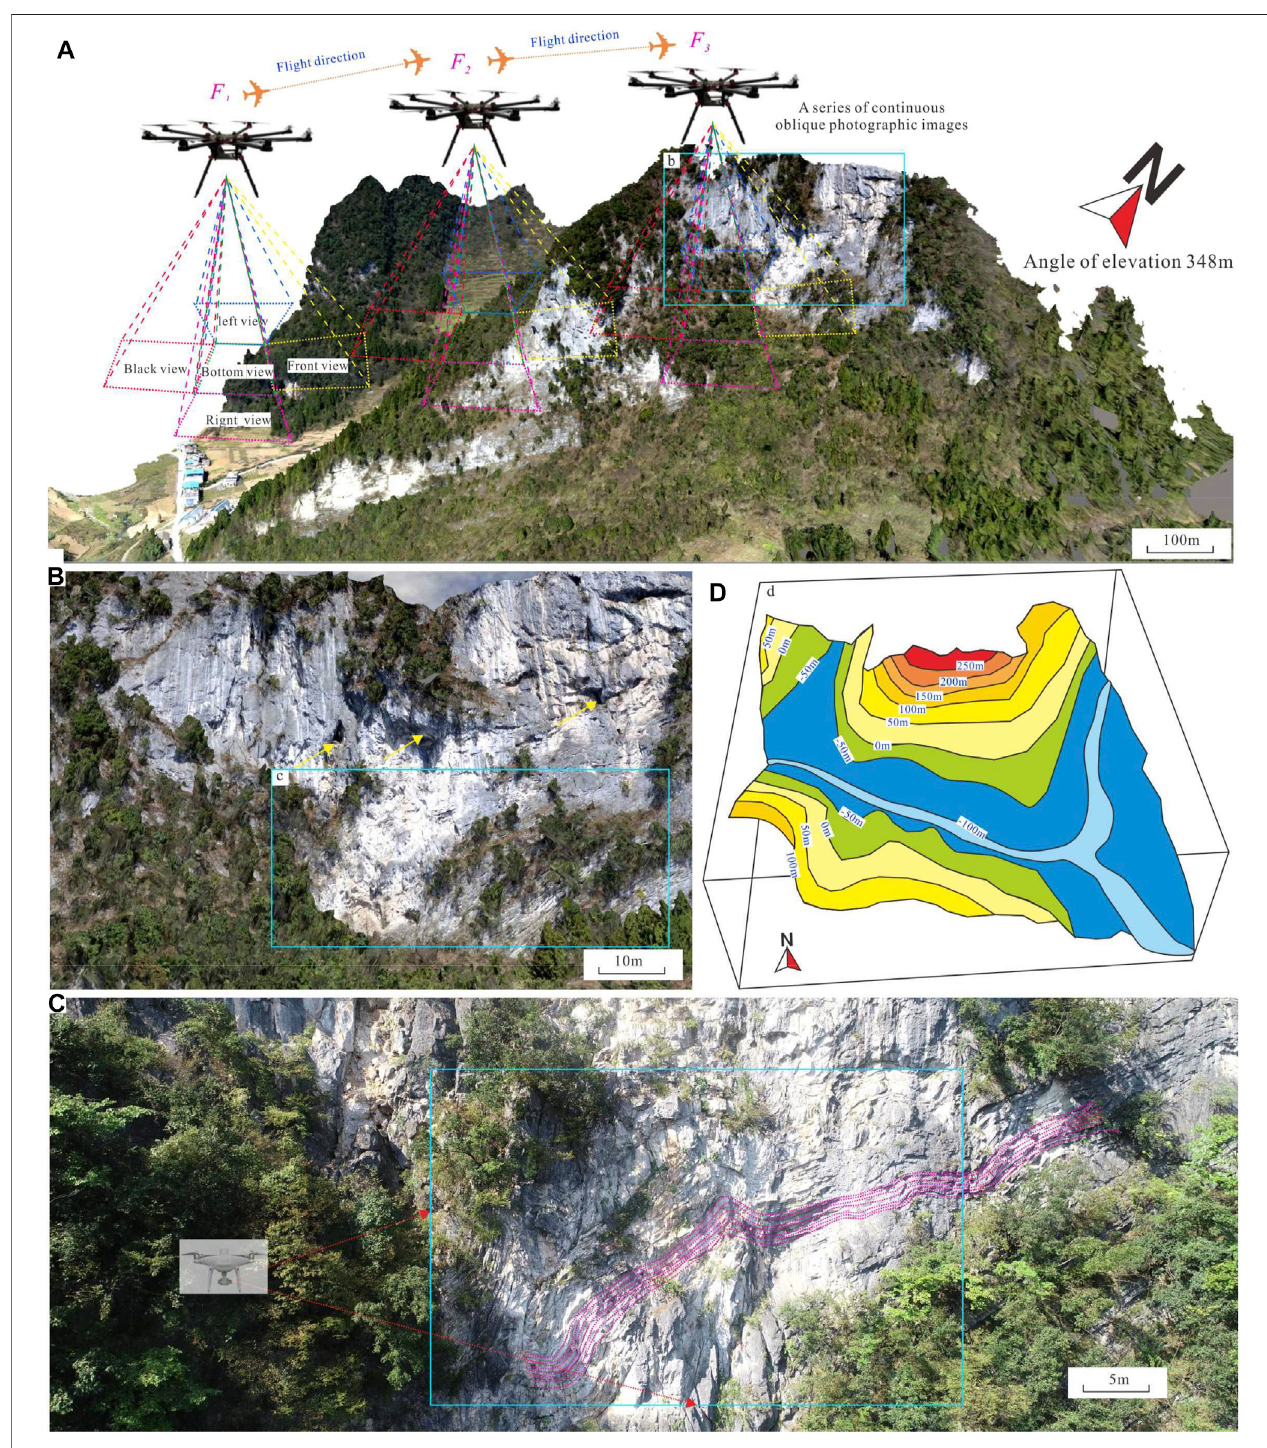
FIGURE 2 | Technology of UAV oblique photographic and outcrop area elevation contour map. (A) A series of continuous oblique photographic images; (B) picturesobtainedbyUAVobliquephotographic; (C) picturesobtainedbyUAVobliquephotographicwithdepositiondetails; (D) elevationcontourmapobtainedbyUAV.